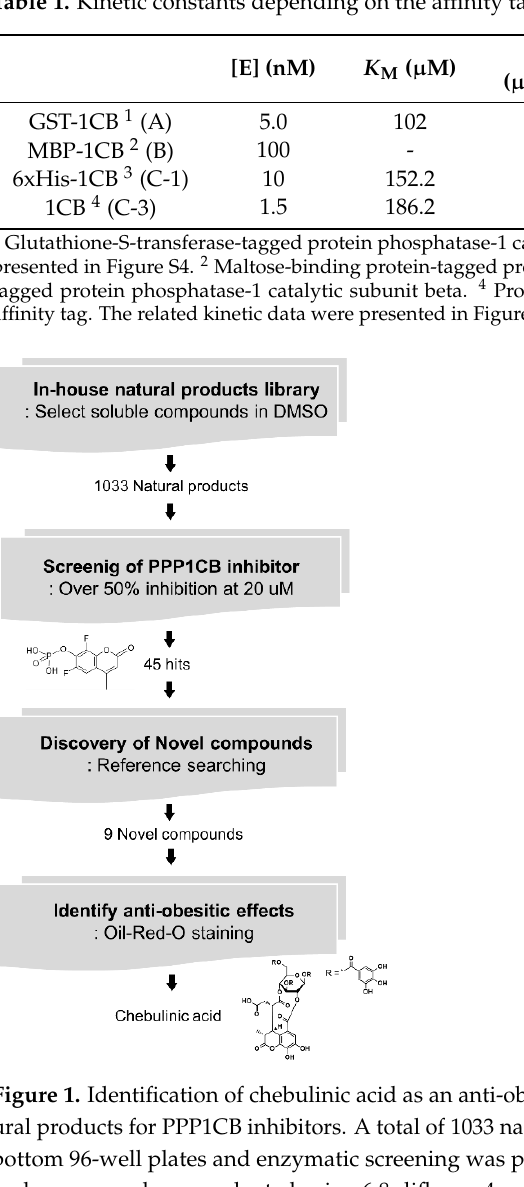
Table 1. Kinetic constants depending on the affinity tags.